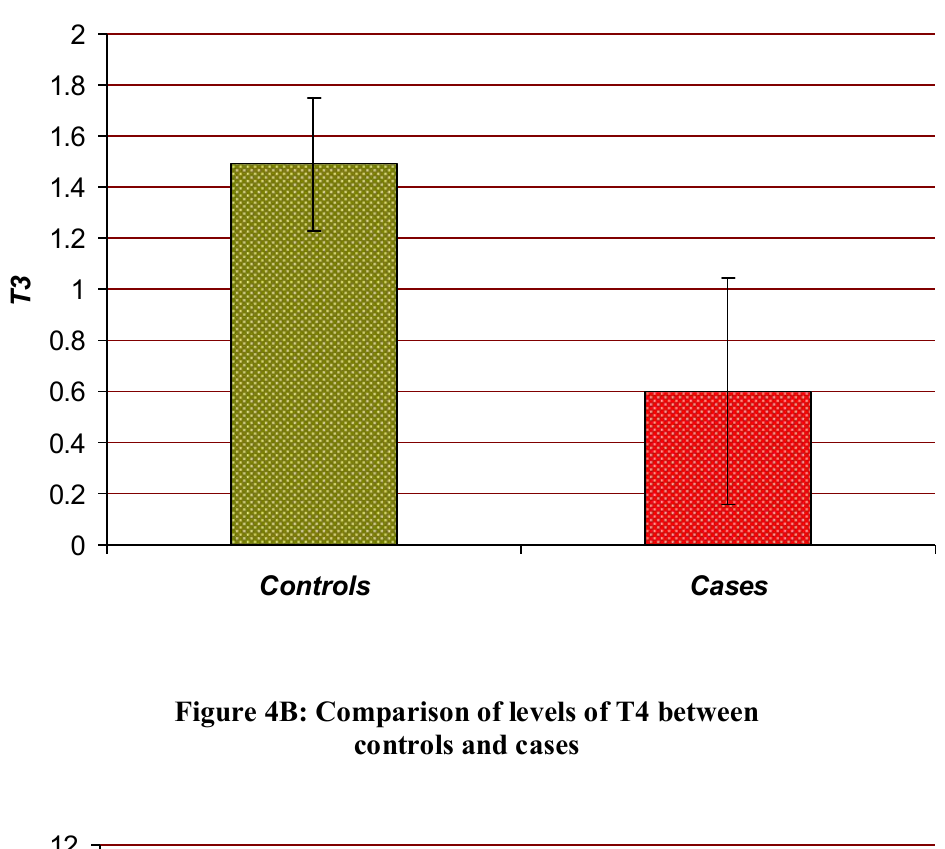
Figure 4A: Comparison of levels of T3 between controls and cases